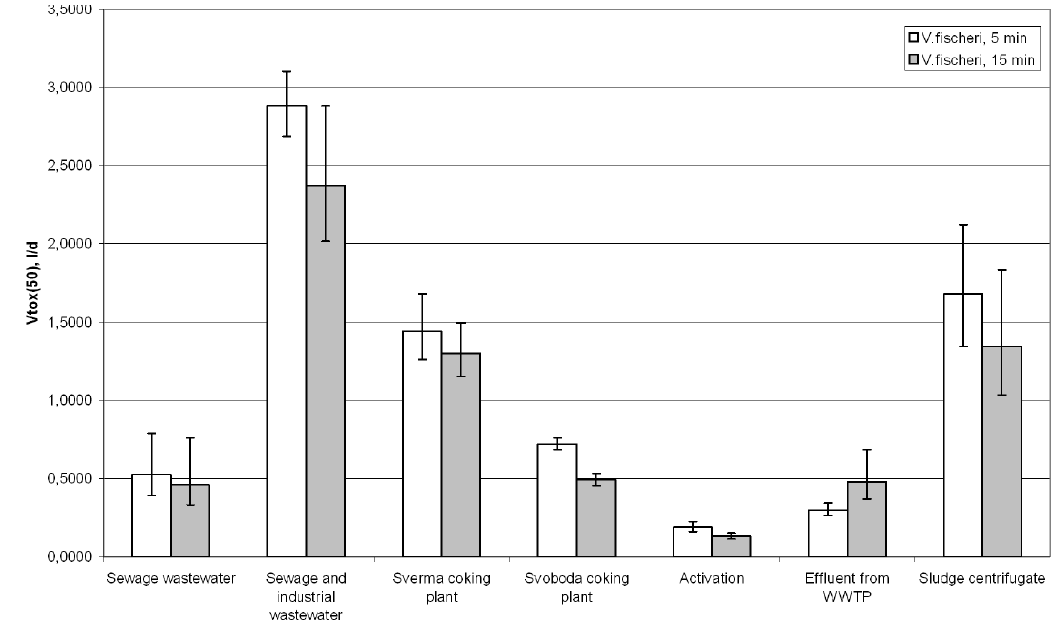
Fig. 2 Toxicity of SPMD samples from monitored pro› les in WWTP to Vibrio ›